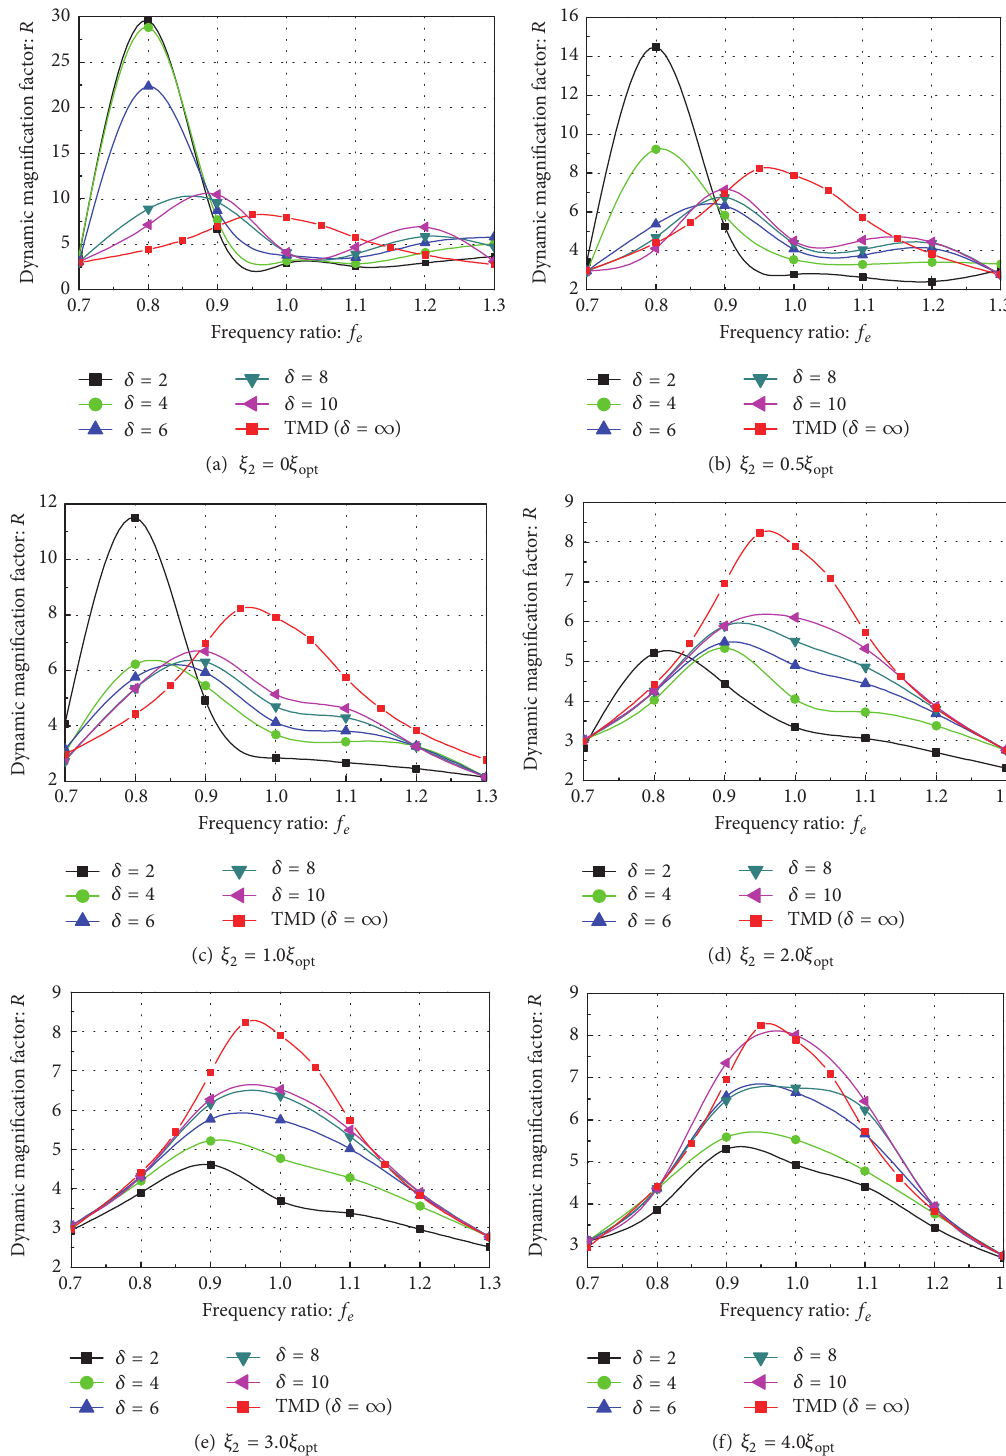
Figure 5: Responses of the controlled structure with different damping